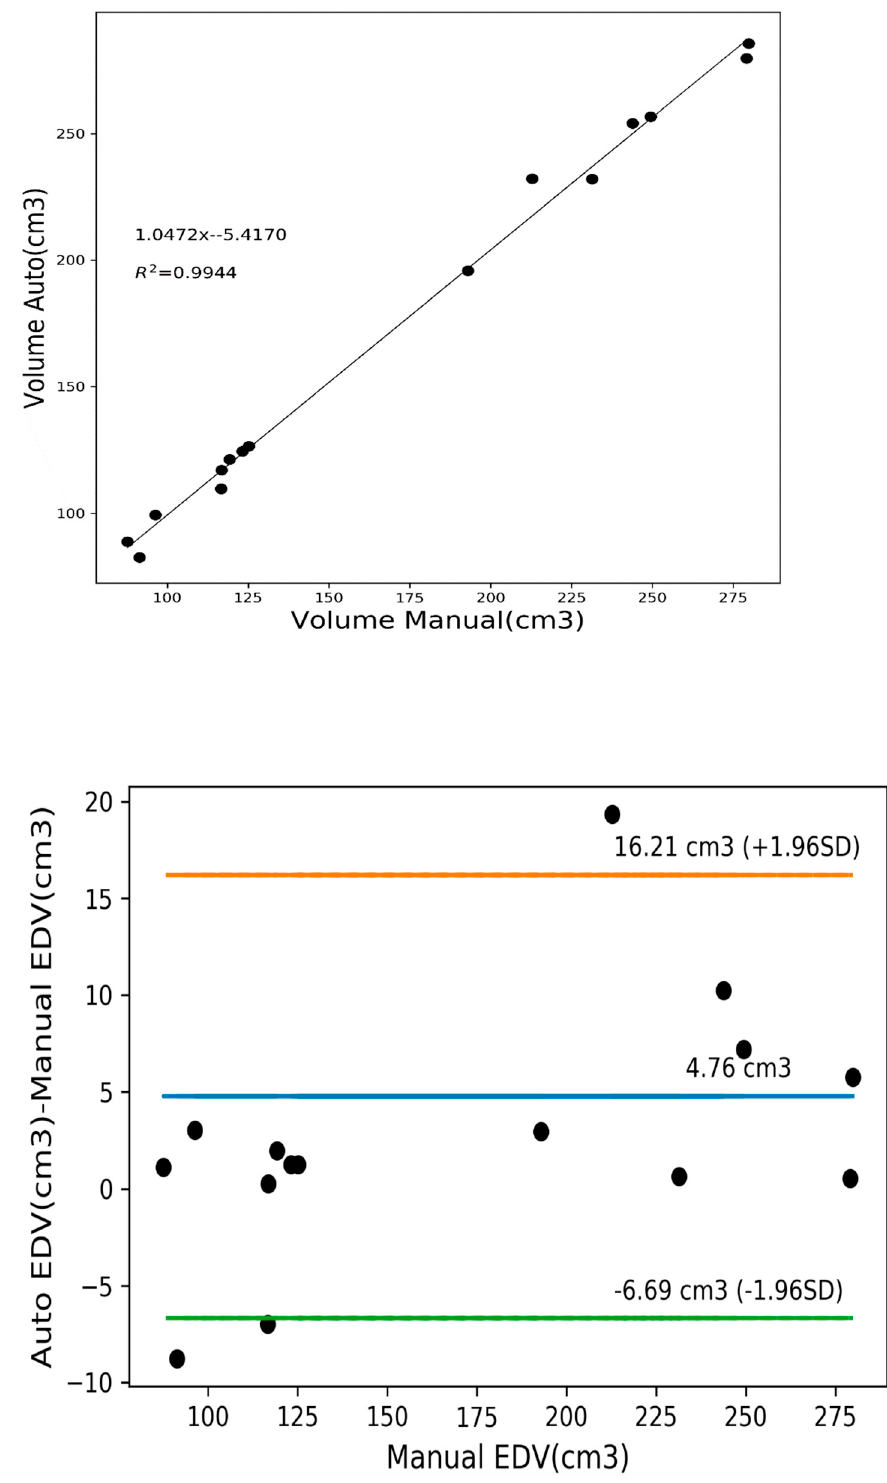
Figure 23. Linear regression plot (Top) and Bland-Altman plot(Bottom) for EDV.